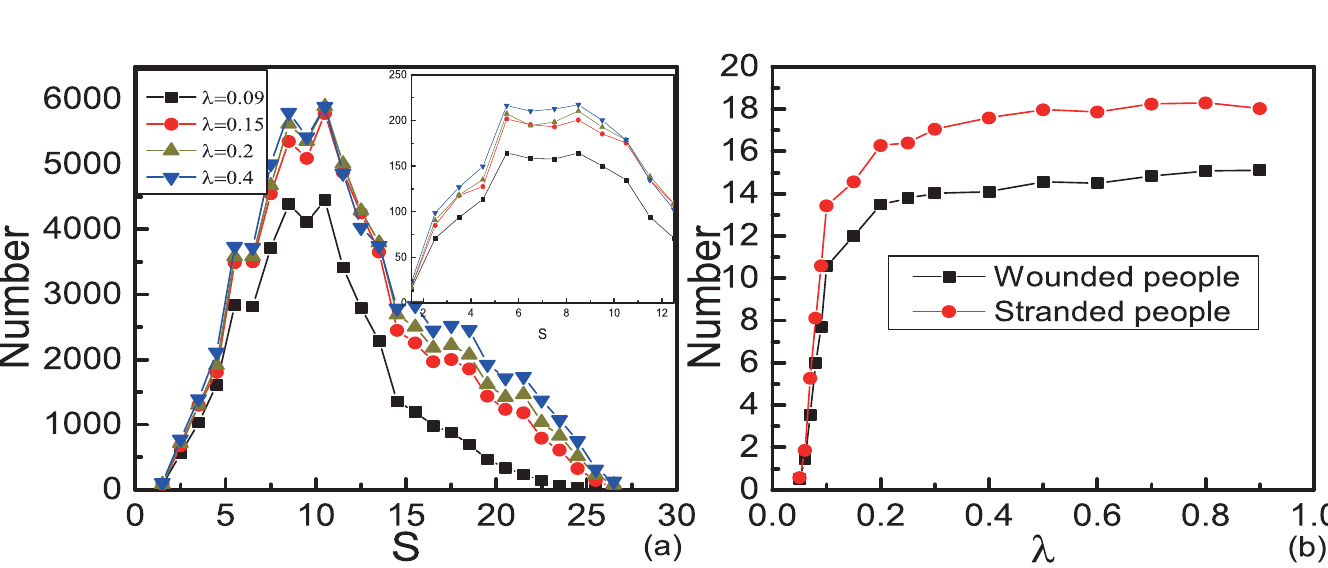
Fig 8. Number of wounded and stranded people with variable motion mode. Here, p w , I = 0.001 and p w , II = 0.0001. Initially, N II = 5. (a)The distribution of the distances from wounded people to the exit. The inset graph displays the distribution of the number of wounded people per unit area. The data are obtained by 5000 different realizations. The horizontal ordinate of every points S is the median of internal [ S − 0.5, S + 0.5]. (b)The numbers of wounded people and stranded people as functions of λ . The data points are obtained by averaging over 500 different realizations.